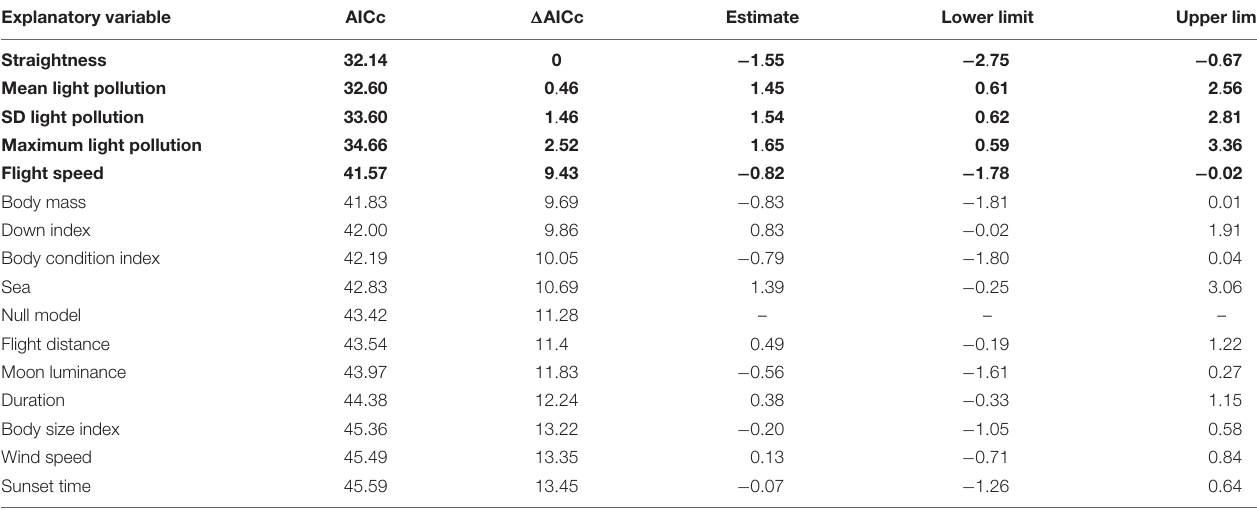
TABLE 4 | Univariate GLMs explaining the probability of being grounded ranked by AICc. Explanatory variable AICc (cid:49) AICc Estimate Lower limit Upper